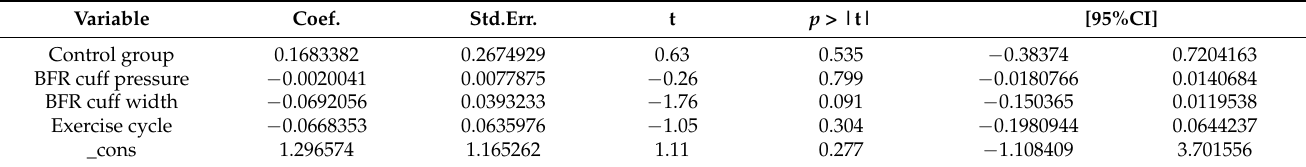
Table 4. Results of meta-regression analysis on resting hemodynamic outcomes. Variable